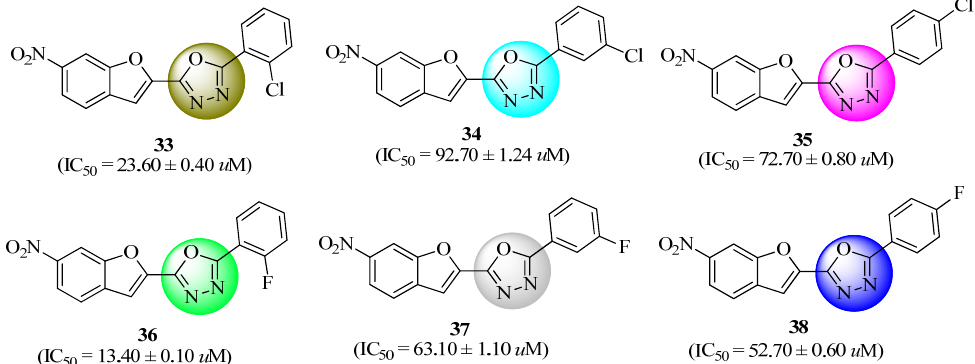
5-aryl-2-(6’-nitrobenzofuran-2’-yl)-1,3,4-oxadiazole derivatives and tested them for their